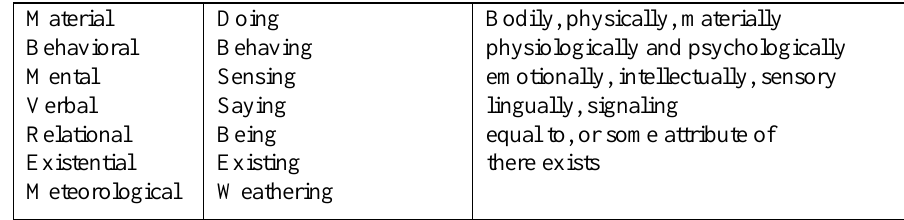
Table 1. Seven Types of